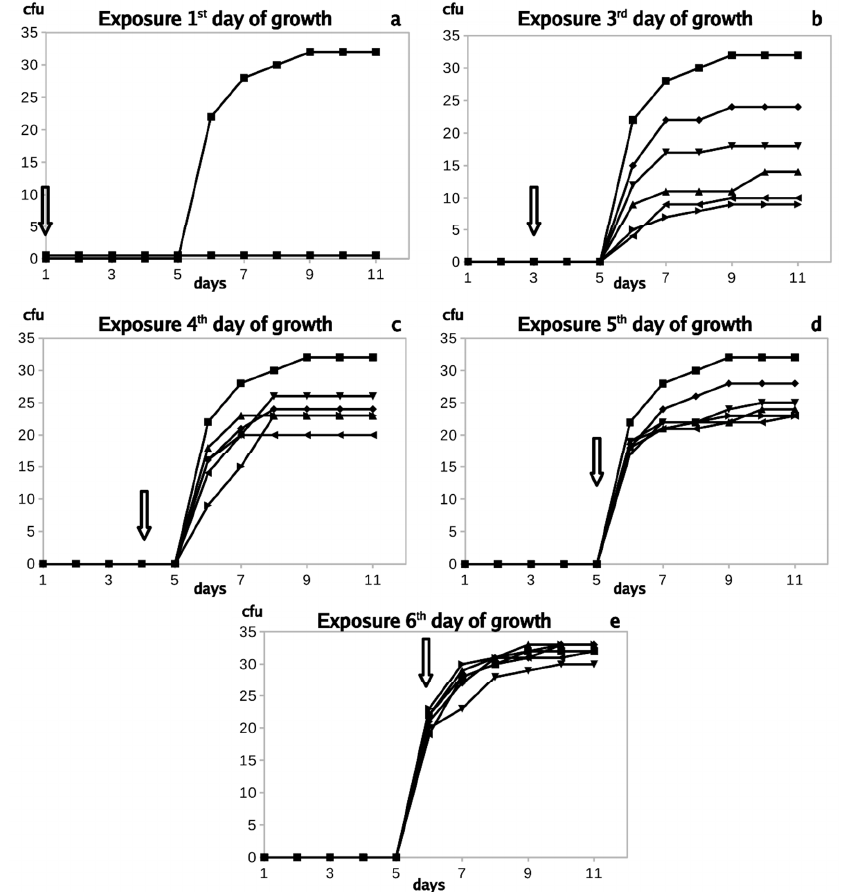
Figure 8. Colony-forming units (cfu) of Trichophyton interdigitale exposed on the first ( a ), third ( b ), fourth ( c ), fifth ( d ), and sixth ( e ) day after inoculation. The lines are interlaced as a moving average. The upper line and full rings represent unexposed culture; the lower curves (coinciding with the x-axis) represent experimental series. ( a ) 1----, 12---, 123--, 1234-, and 12345; ( b ) 3----, 34---, 345--, 3456-, and 34567; ( c ) 4----, 45---, 456--, 4567-, and 45678; ( d ) 5----, 56---, 567--, 5678-, and 56789; ( e ) 6----, 67---, 678--, 6789-, and 678910. Error bars are not inserted for better picture clarity. An arrow marks the NTP exposure.